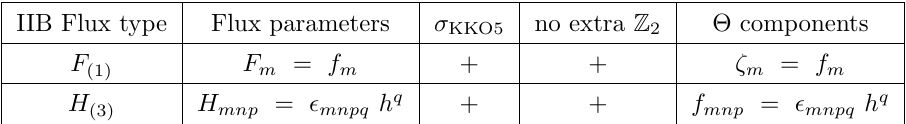
Table 14 . The explicit dictionary between type IIB (cid:13)uxes consistent with the O5 involution and deformation parameters of N = (1 ; 1) supergravity in six